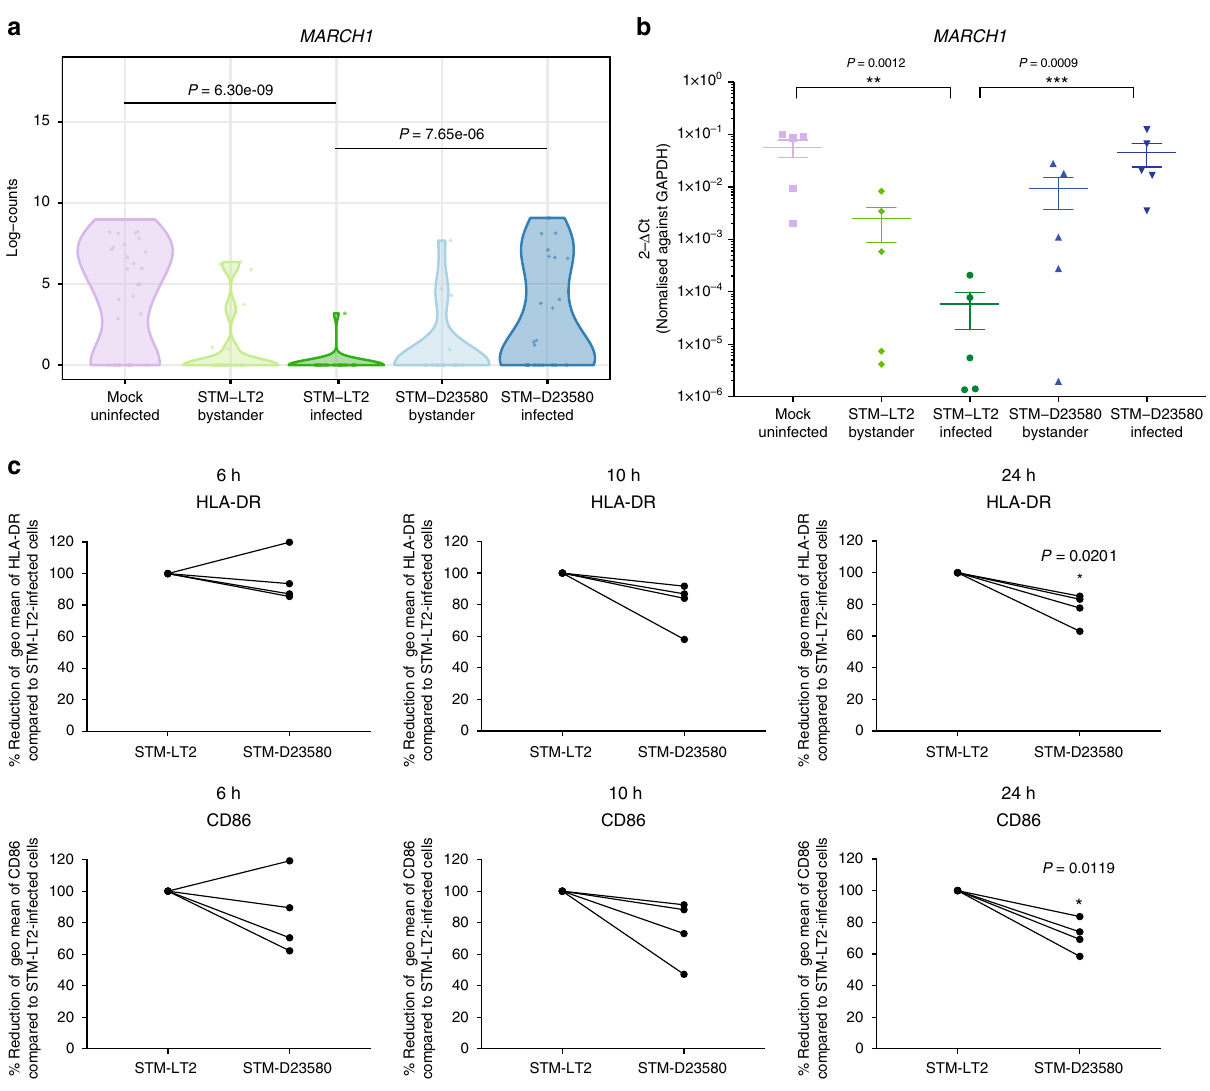
Fig. 7 Intracellular STM-D23580 reduces HLA-DR and CD86 surface expression compared to STM-LT2. a Violin plot showing single-cell gene expression of MARCH1 at 6 h p.i. in all the experimental groups. b Dot plot showing gene expression of MARCH1 at 6 h p.i detected by qPCR in all experimental groups. The mean±SEM of fi ve independent experiments is shown. Two-way ANOVA test, P -value < 0.01(**), <0.001(***). c Surface HLA-DR and CD86 expression measured by fl ow cytometry. On the y -axis, the geometric mean of fl uorescence levels for HLA-DR and CD86 on STM-D23580-infected cells is represented as a percentage of the level in STM-LT2 infected cells, set at 100%. Four independent experiments are shown. Two-tail paired Student ’ s t -test, P -value < 0.05